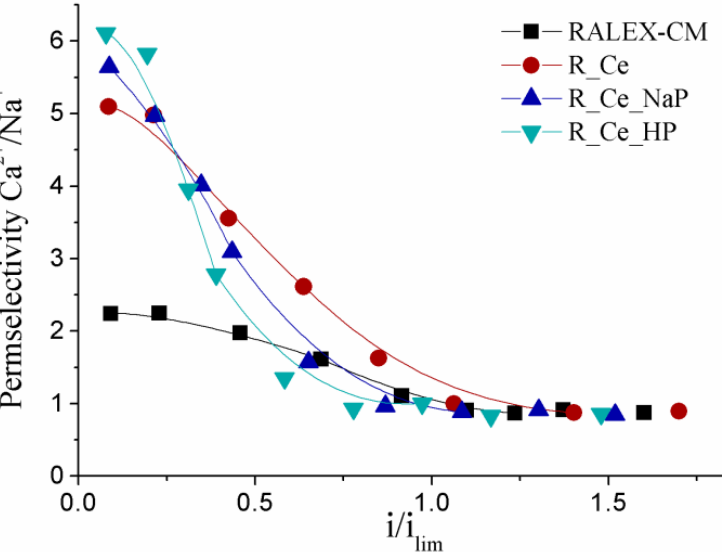
Figure 5. Dependence of selective permeability (P Ca/Na ) of the modified membranes on the normal- ized current density (i/i lim ) in 0.03 mol-eq/L solution of NaCl and CaCl 2 at a membrane disk rotation rate of 100 rpm.